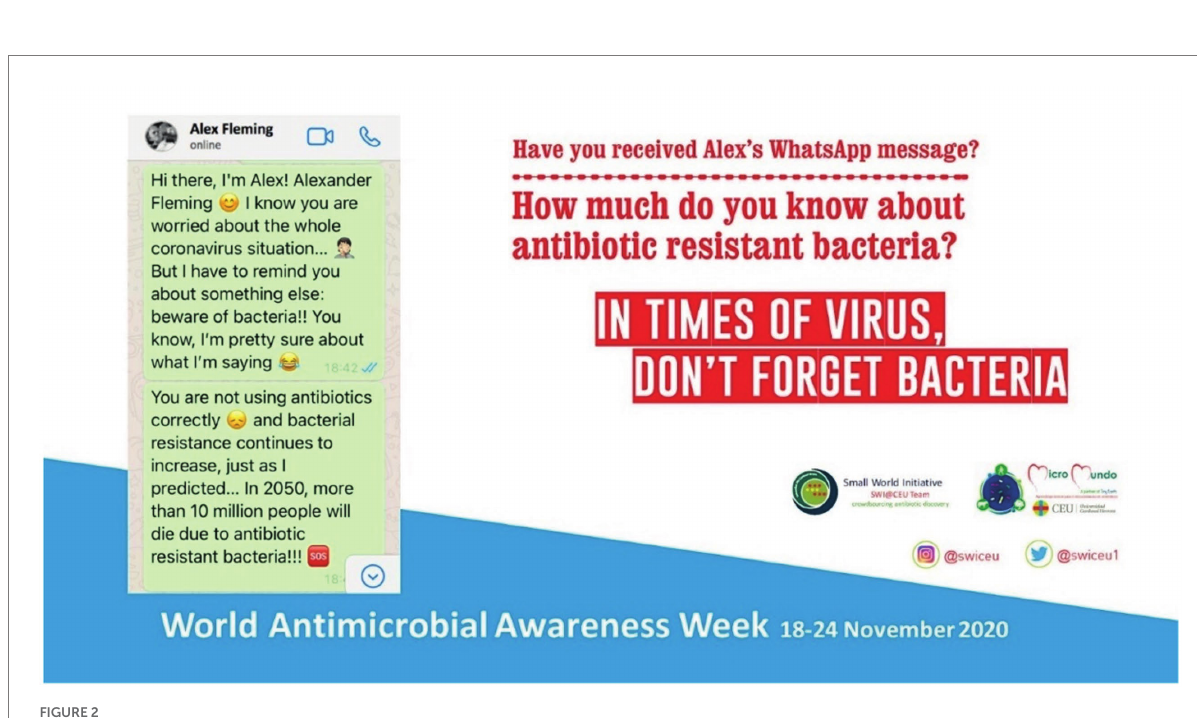
FIGURE 2 2020 campaign poster “In times of virus, do not forget